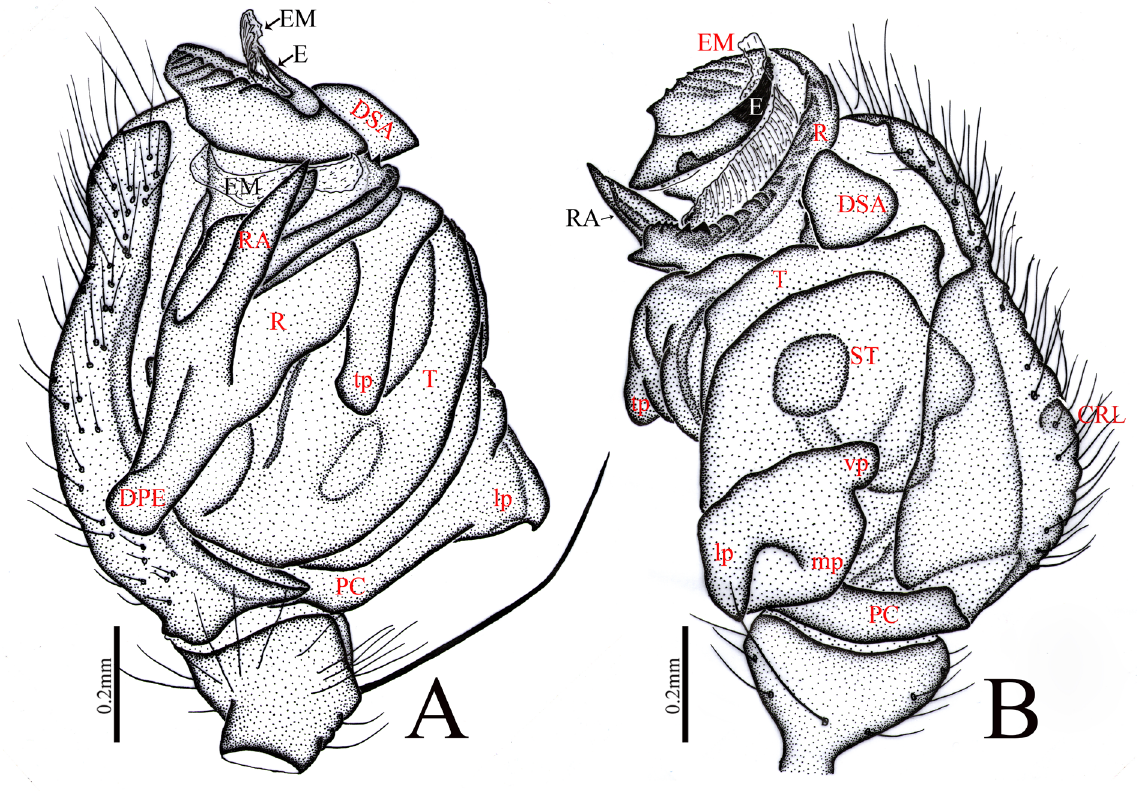
Fig. 16. Acroterius circinatus gen. et sp. nov., ♂, holotype (HNU-CGY137), palp. A . Prolateral view. B . Retrolateral